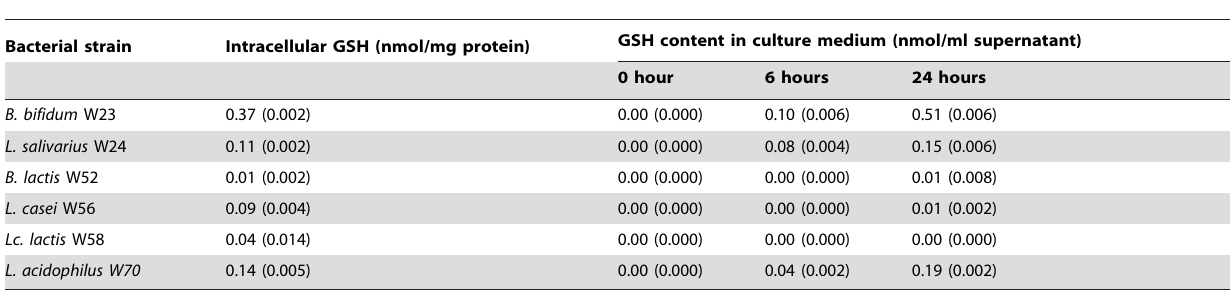
Table 1. Intracellular GSH contents of the probiotic strains and GSH levels in medium at different time points after start of